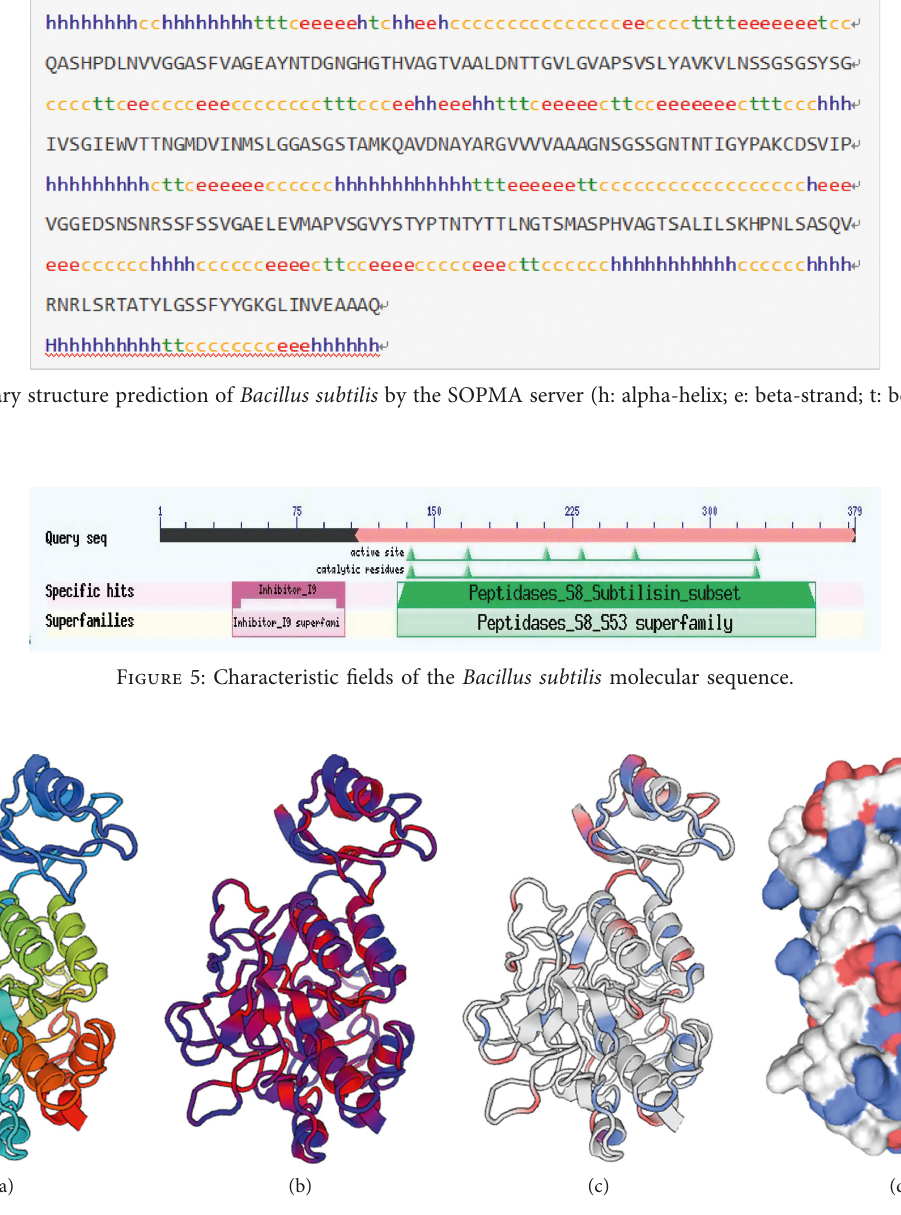
Figure 6: Tertiary structure of the Bacillus subtilis protein. (a–d) Structure diagrams marked with different colors. (a) Rainbow: (N-terminus ⟶ C-terminus). (b) Hydrophobic: (least hydrophobic ⟶ most hydrophobic). (c, d) Charged: red (negative) and blue